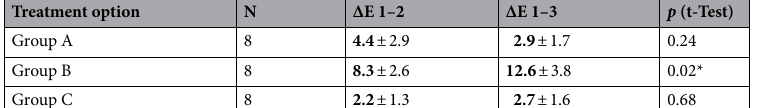
Treatment option